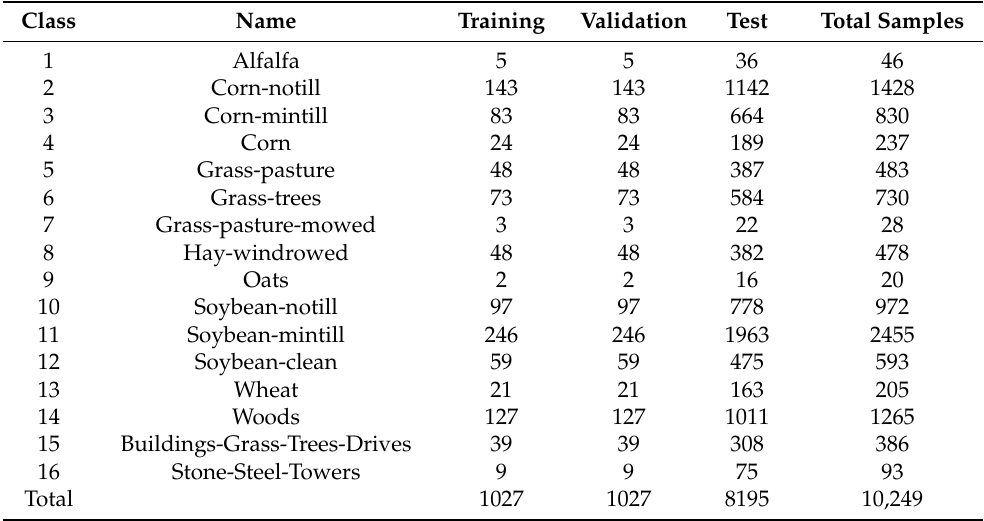
Table 1. Number of training, validation, and testing samples for the IP dataset.